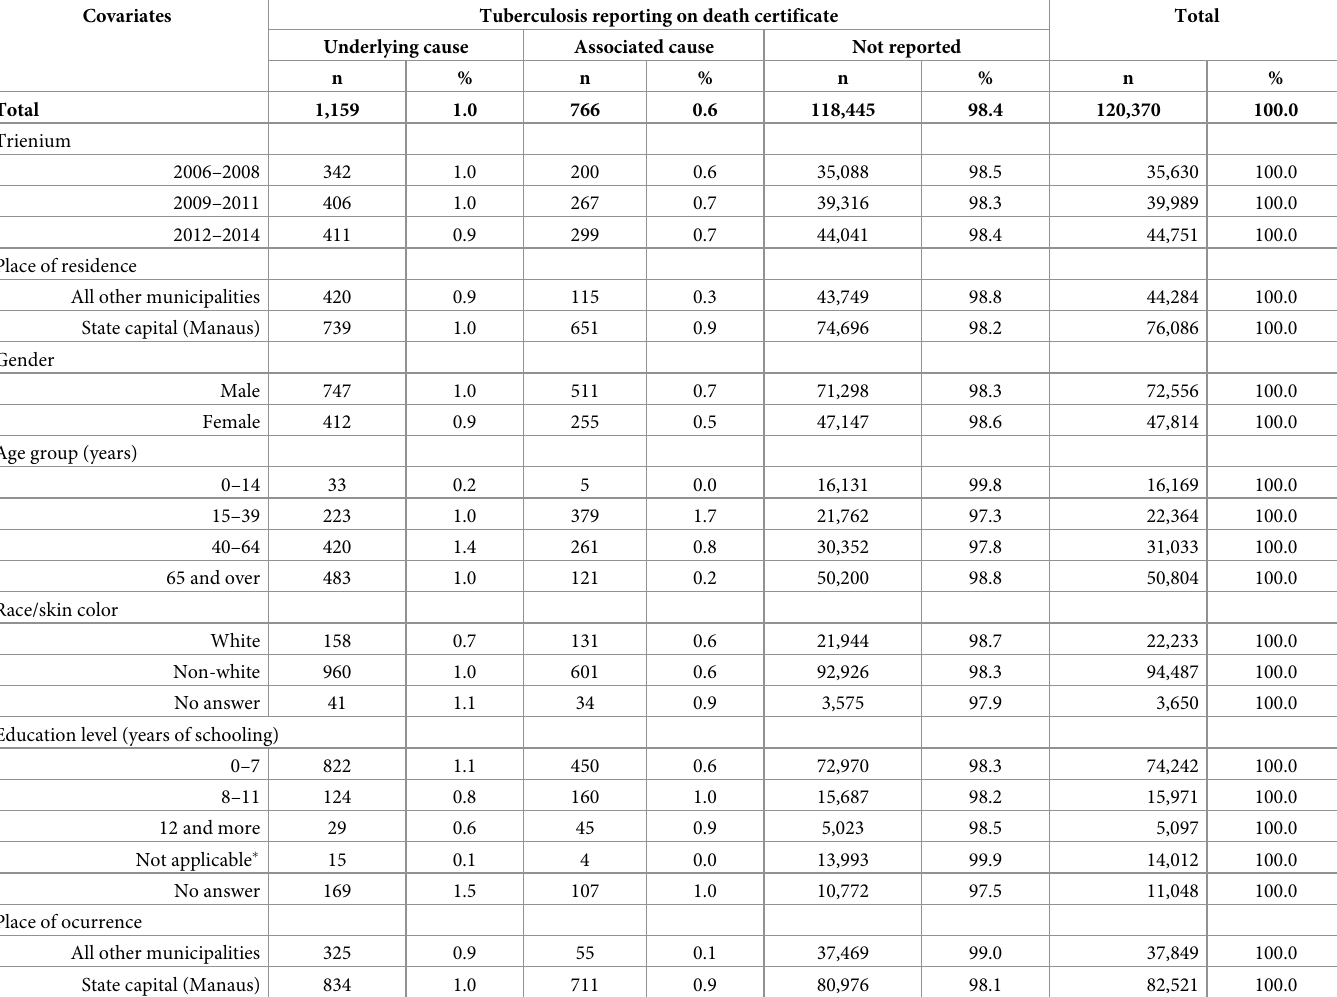
Table 1. Distribution of death records according to categories of covariates and tuberculosis § reporting as cause of death, state of Amazonas, Brazil, 2006 to 2014.